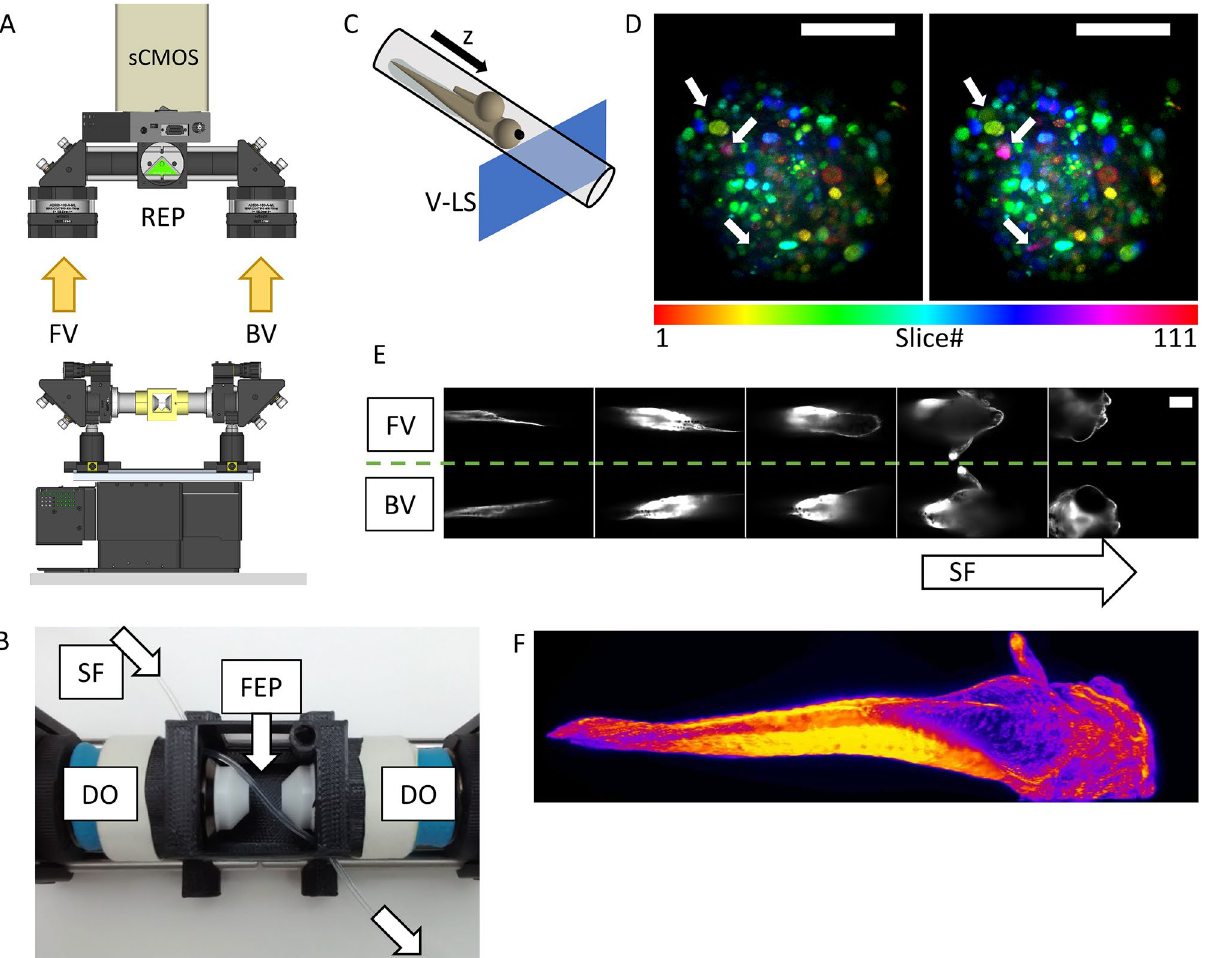
Figure 4. ( A ) The setup implementation in the Flow LSFM modality with double simultaneous detection scheme. ( B ) The imaging chamber embedding two sealed water detection objective (DO) and a FEP tube crossing it at 45°. SF sample flow. ( C ) Exemplification of the sample mounting and scanning system. The sample flows within the FEP tube through a vertical light-sheet. ( D ) Depth-colored maximum intensity projection of a fixed tissue spheroid expressing a histone H2B fluorescent nuclear reporter protein (mCherry), obtained through single (left) and double (right) side detection scheme. The fusion of two views (on the right) reveals nuclei that would be otherwise missed through single side detection (see white arrows). Scale bars 100 µm. ( E ) Series of images during the flow of a Fli-GFP zebrafish embryo through the system. The front view (FV) and the back view (BV) are simultaneously registered on the same camera chip. Scale bar 100 µm. ( F ) 3D reconstruction view of the same zebrafish showed in ( E ). Colors represent signal intensity (Fire LUT in Fiji). ( A ) created with FreeCAD 0.16 (www. freec adweb. org) and ( C ) created with Autodesk Inventor Professional 2015 (www. autod esk.